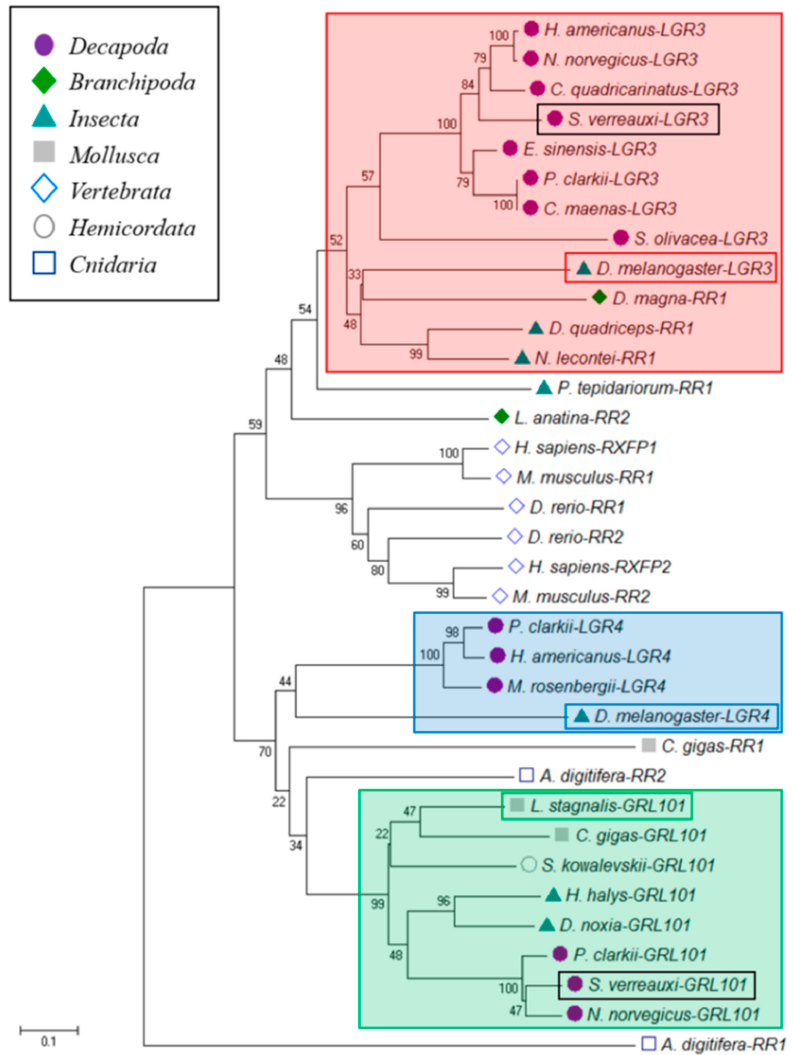
Figure 4. Neighbor-joining phylogram of the 7 transmembrane domains (7TMs) of dLGR3, dLGR4, and GRL101 homologs identified in eight decapod species; bootstrap values are shown at each node and were performed with 1000 replicates. The scale bar indicates number of amino-acid substitutions per site and key highlights the taxonomy. dLGR3 is boxed in red, dLGR4 is boxed in blue, and LGR101 is boxed in green, with all of the model species emphasized in boxes of corresponding colors.